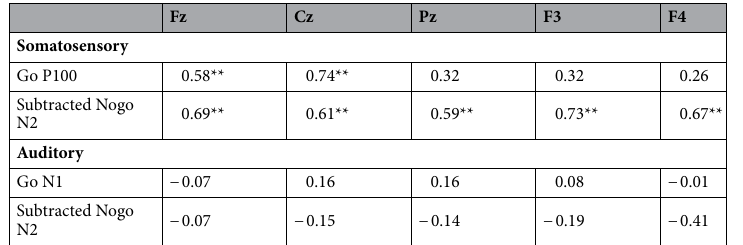
Table 3. The r values of correlations between Go/Nogo RT and the latencies of modality specific components and supramodal components at the five electrodes in the somatosensory and auditory modalities. ** p < 0.01.